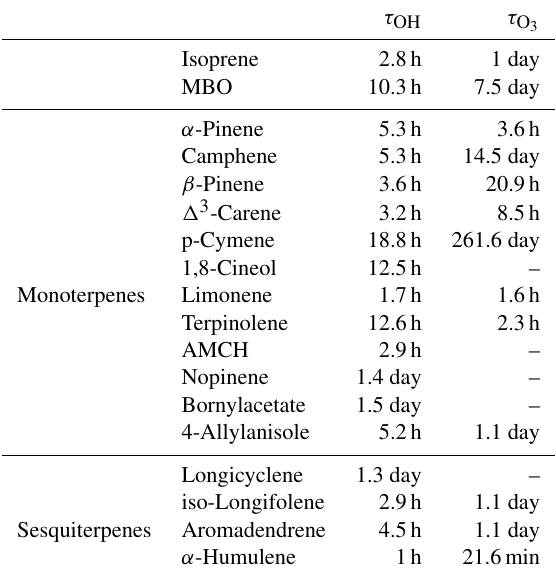
Table 1. Lifetime ( τ) of BVOCs calculated for the average concen- tration of OH radicals (ca. 0.04pptv) as reported by Ciccioli et al. (2014) and the annual average O 3 (ca. 36ppbv) concentration mea- sured for the two campaigns at